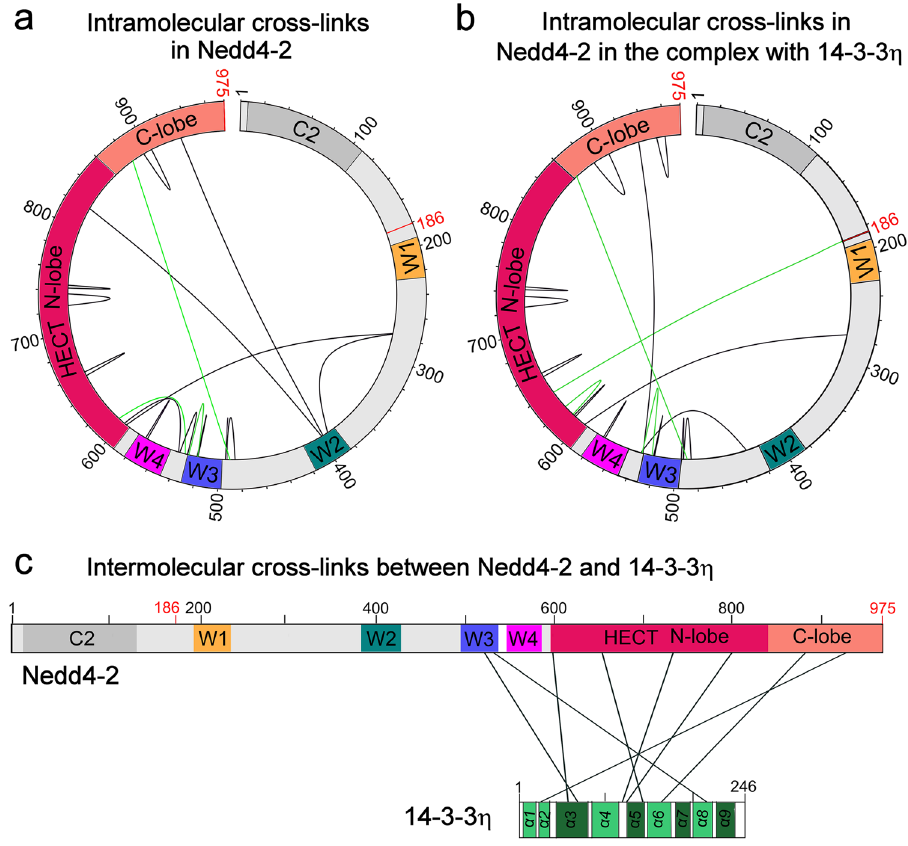
Fig. 6 Schematic representation of intra- and intermolecular crosslinks in Nedd4-2 and between Nedd4-2 and 14-3-3 η . a Schematic representation of intramolecular crosslinks of Nedd4-2 186 – 975 alone (black) with a 50-fold molar excess of DSG (Supplementary Table S1) and quantitative crosslinks with a 50-fold molar excess of 12 C and 13 C DSA in pale green (Supplementary Table S3). b Schematic representation of intramolecular crosslinks of Nedd4- 2 186 – 975 in a complex with 14-3-3 η (black) with a 50-fold molar excess of DSG (Supplementary Table S2) and quantitative crosslinks with a 50-fold molar excess of 12 C and 13 C DSA in pale green (Supplementary Table S3). c Schematic representation of intermolecular crosslinks between Nedd4-2 186 – 975 and 14-3-3 η mixed at a 1:2 stoichiometry with a 50-fold molar excess of DSG or DSS (black) crosslinking agent (Supplementary Table S4). Nedd4-2 186 – 975 diagram: the C2 domain, not present in the Nedd4-2 186 – 975 construct, is shown in grey, the WW domains (denoted as W1-4) are shown in yellow, teal, blue and magenta, and the HECT domain N- and C-lobes are shown in raspberry and salmon, respectively. The beginning and the end of the Nedd4- 2 186 – 975 construct are labeled in red. 14-3-3 diagram: colored regions represent α -helices of the 14-3-3 molecule (shown in green), and the helices that form the ligand binding groove ( α 3, α 5, α 7 and α 9) are colored in dark green. This fi gure was prepared using the xiVIEW (https://xiview.org/) and InkScape (http://www.inkscape.org/)